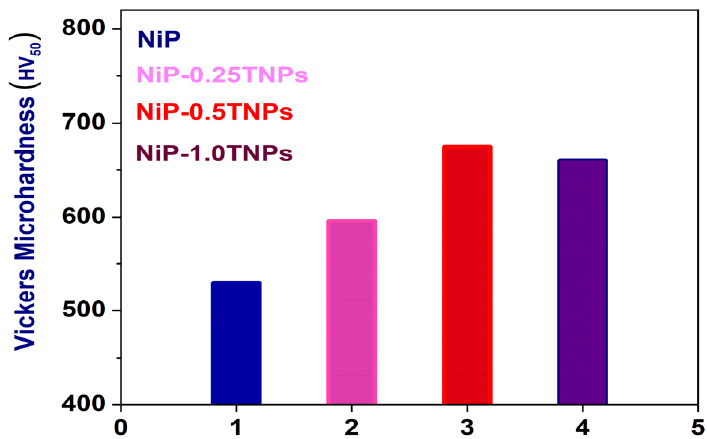
Figure 6. Vickers microhardness results for NiP, NiP-0.25TNPs, NiP-0.5TNPs, and NiP-1.0TNPs nanocomposite coatings.